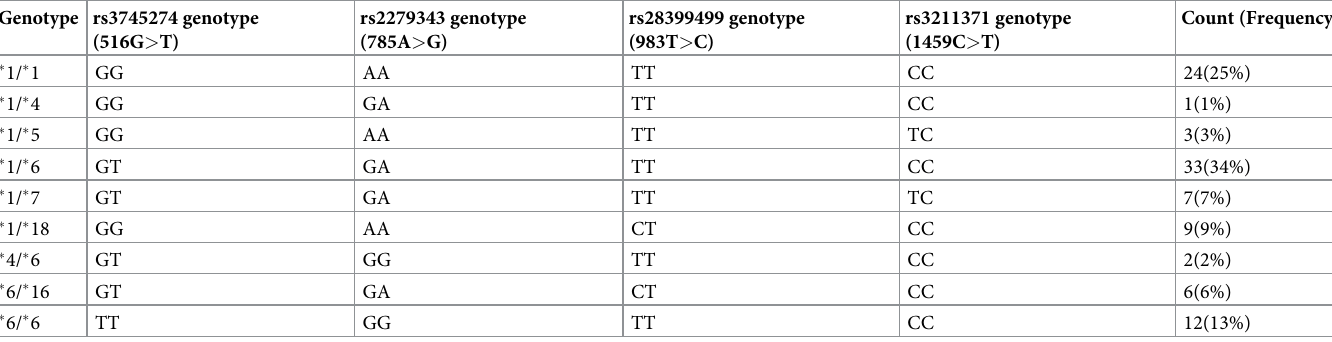
Table 4. Distribution of single nucleotide polymorphisms and relationship to CYP2B6 genotype among study participants. Genotype rs3745274 genotype (516G >